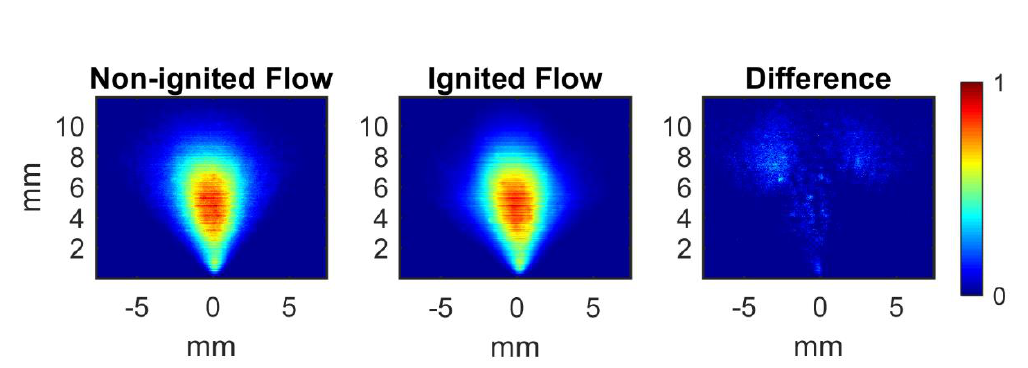
Figure 7. Mie scattering images of ethanol spray at four equivalence ratios. The O 2 flow rate was fixed at 0.4 L/min.